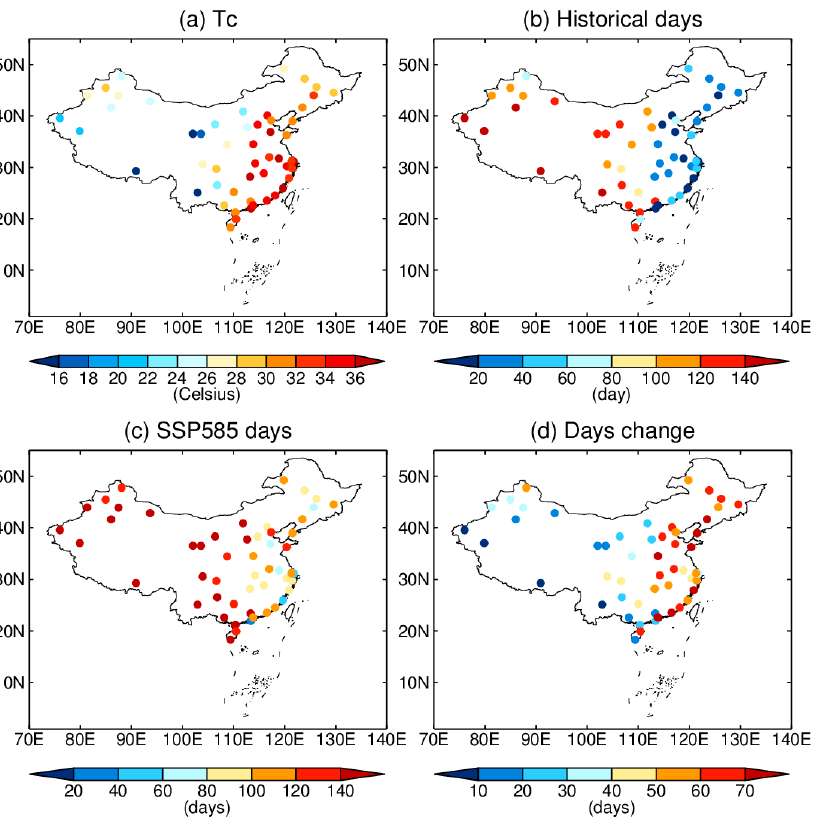
Figure 3. ( a ) 𝑇 (cid:3030) of the 53 airports in China. ( b ) The number of days with daily maximum temperature exceeds 𝑇 (cid:3030) during summer in the CMIP6 historical simulation; ( c ) is the same as ( b ), but for the climate projection under the SSP5-8.5 scenario; ( d ) is the difference between ( b ) and ( c ). The plotted data is tabularized in Table S3.